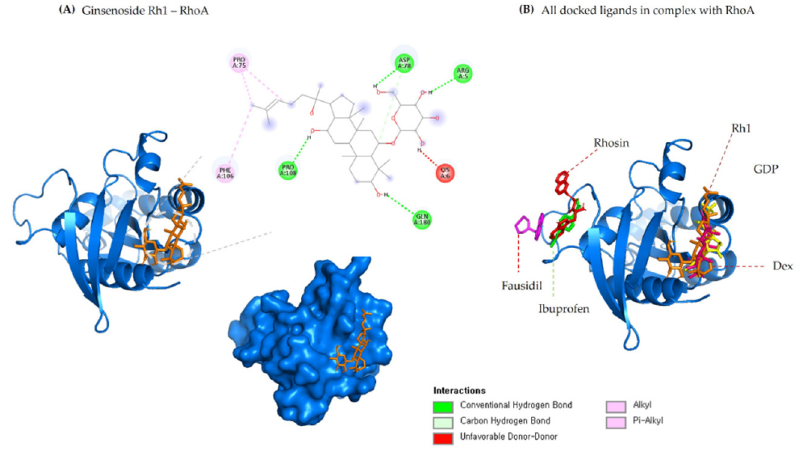
Figure 3. ( A ) 2D & 3D docking interactions of Ginsenoside Rh1 with RhoA. ( B) All docked ligands in complex with RhoA (Orange—Rh1, Pink—Dexamethasone, Yellow—GDP, Magenta—Fausidil, Red—Rhosin, Green—Ibuprofen).